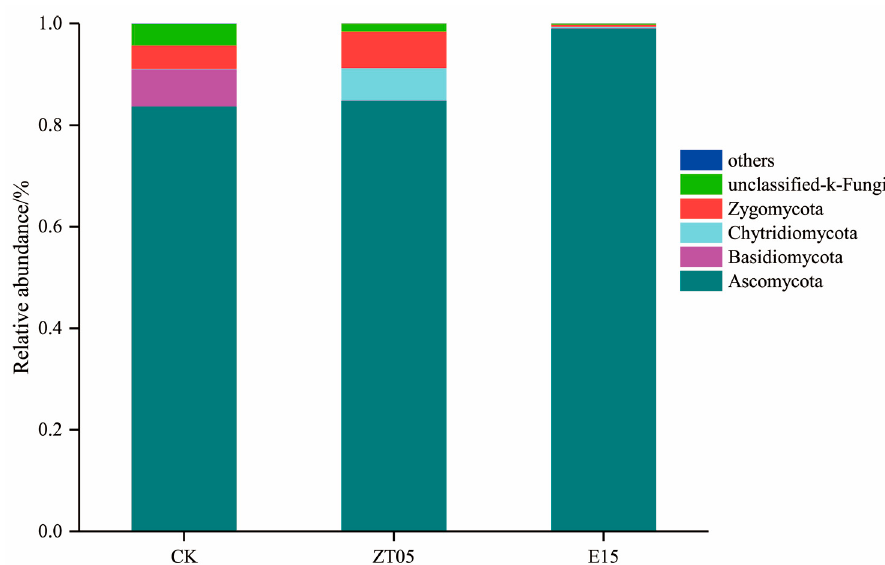
Figure 4. Relative abundance (%) of fungal phyla among CK, ZT05, E15 treatments, based on total sequence reads. CK: inoculation with PD blank culture medium. ZT05: single inoculation with T. virens ZT05. E15: single inoculation with T. harzianum E15.